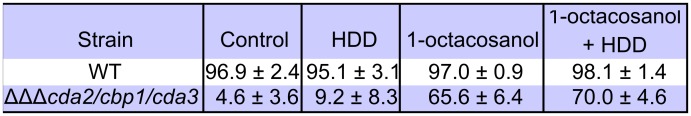
Waxes can partially restore appressorium development in the cda2/cbp1/cda3 mutant.Percentage of germ tubes demonstrating appressorium development in presence of 1-octacosanol and/or 1,16 hexadecanediol, comparing the WT and cda2/cbp1/cda3 strain at 24 hpi.